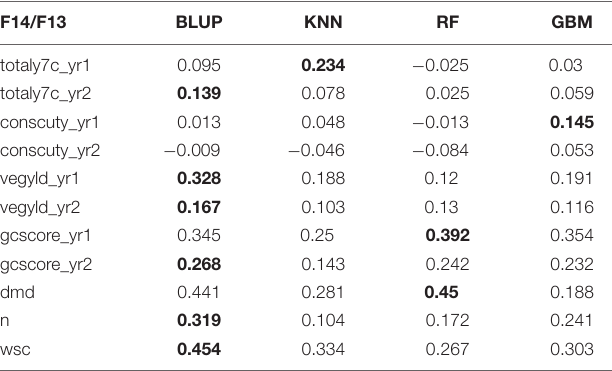
The highest prediction accuracy for each trait is highlighted in bold. Trait identification is as described in Table 1